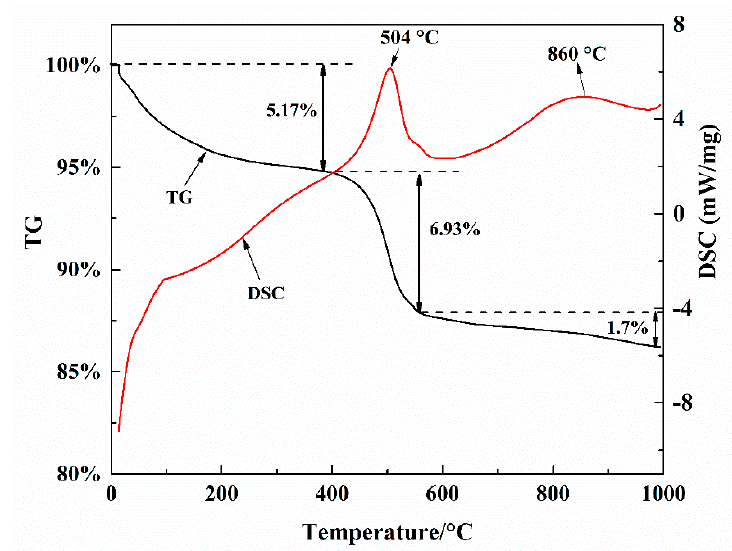
Figure 3. The thermogravimetric analysis (TG) and differential scanning calorimetry (DSC) curves of spent petrochemical catalysts.